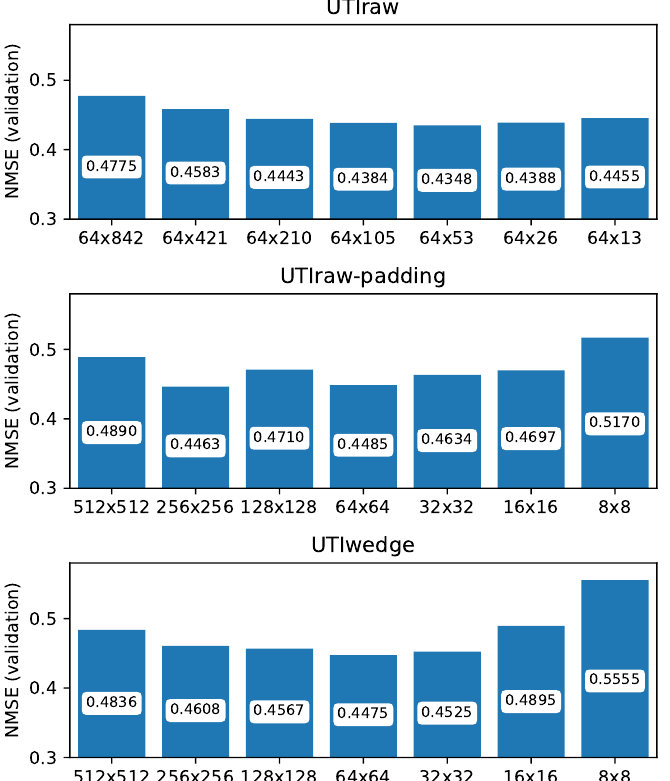
Figure 5. Final validation loss after ResNet-50 training as a function of input image representation and size. UTIraw: ultrasound as raw scanlines; UTIraw-padding: ultrasound as raw scanlines, reshaped to square; UTIwedge: ultrasound as a wedge